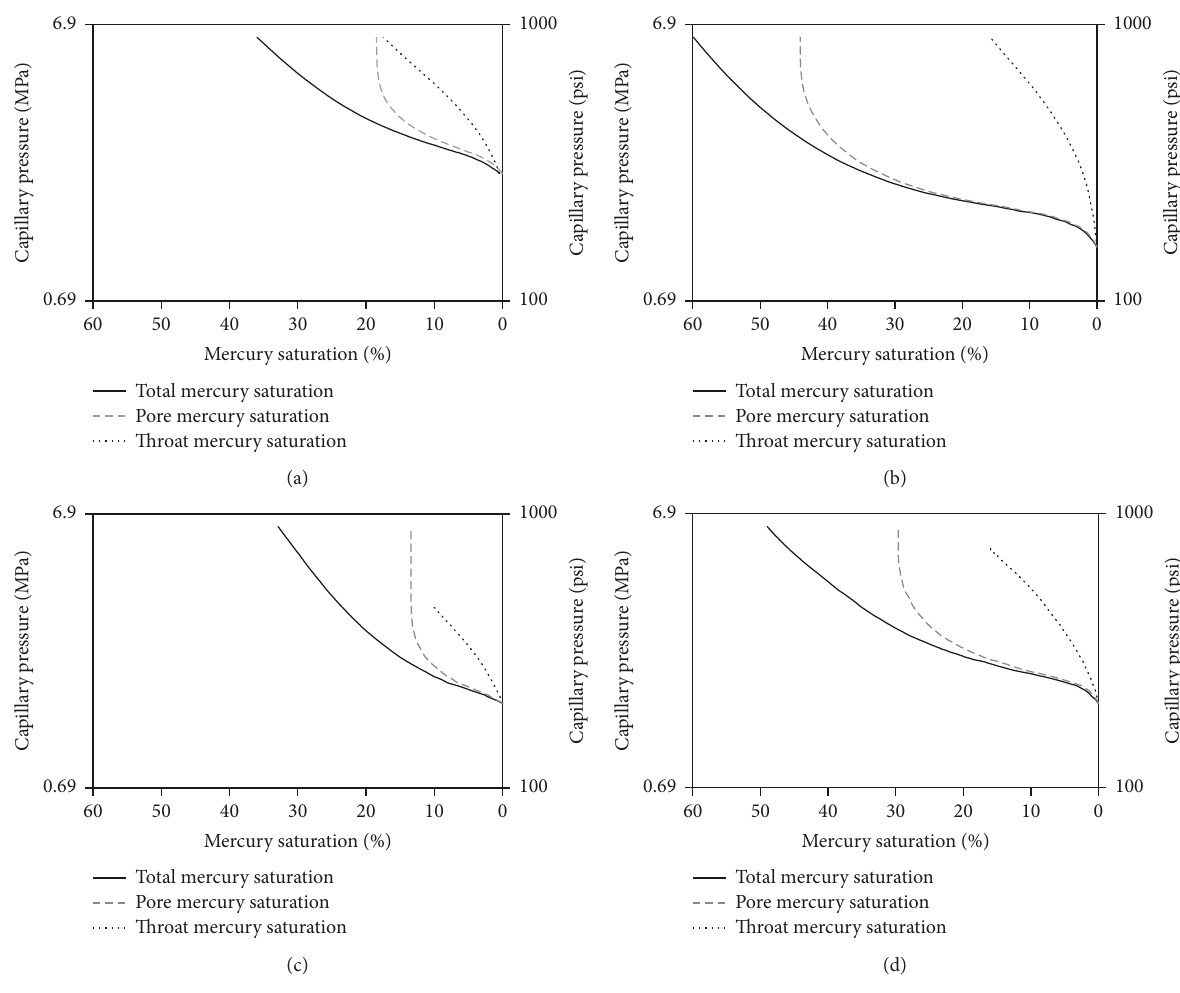
Figure 4: Typical capillary curve plotted with the mercury saturation of the tight clastic rock samples from Upper Triassic Chang 7 Member, Odors Basin. (a) The sample has high threshold pressure (z-8); (b) the sample has low threshold pressure and high mercury saturation